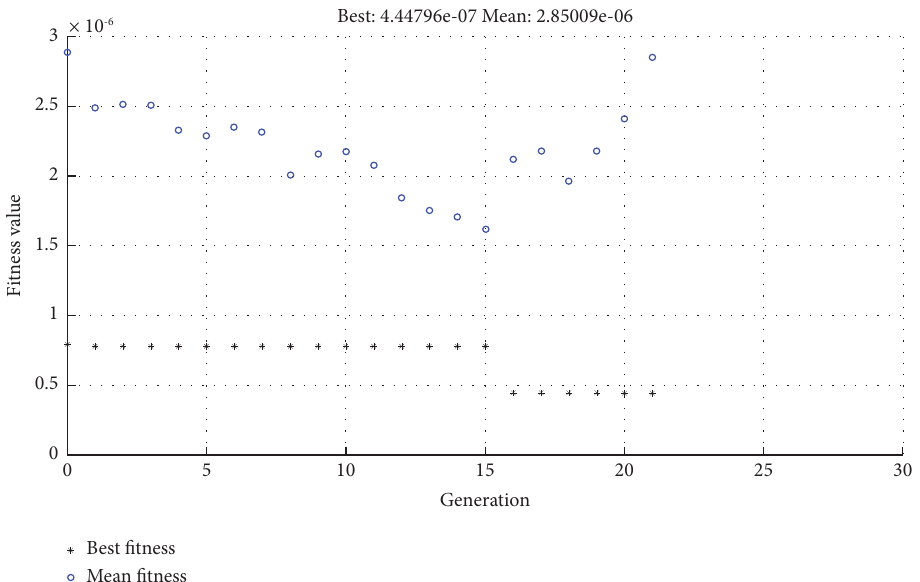
Figure 6: Fitness value of the genetic algorithm